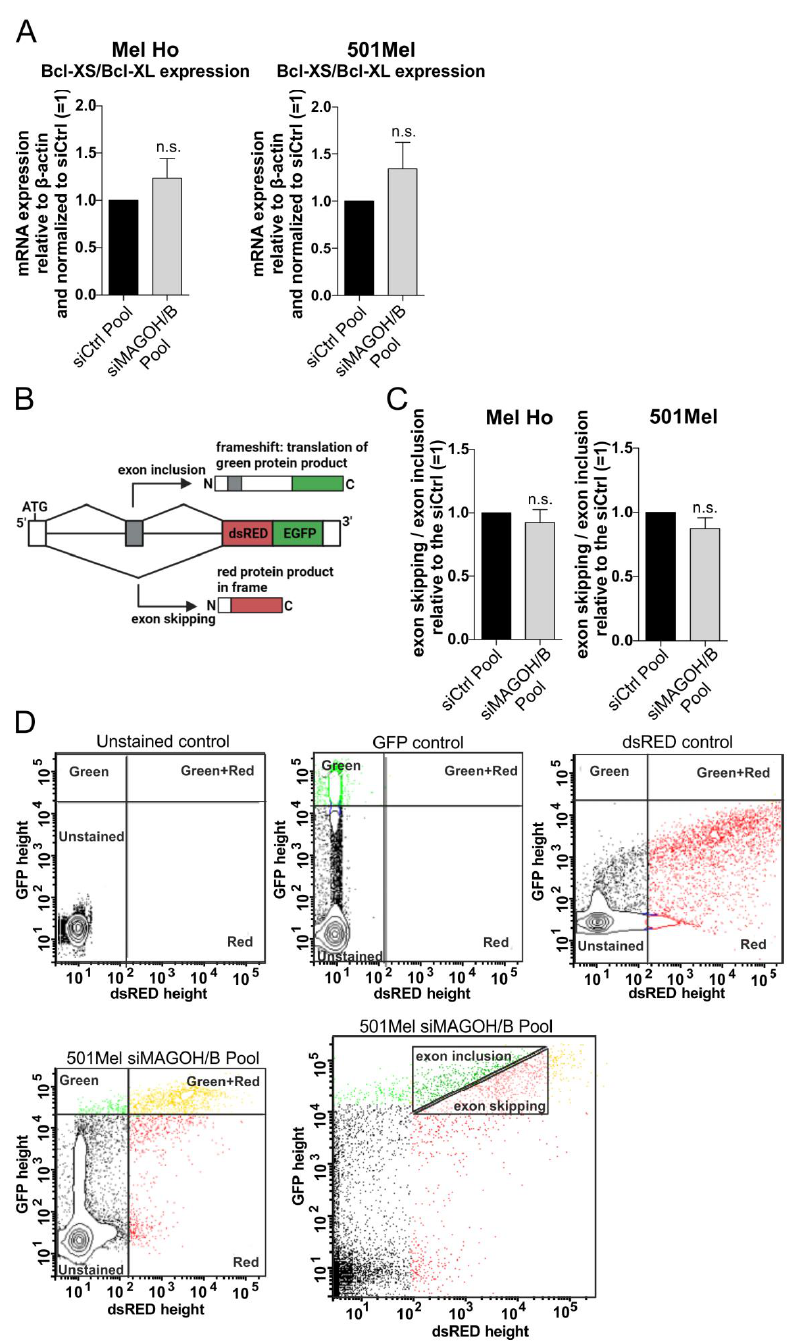
2 Figure 5. MAGOH and MAGOHB do not influence alternative splicing of pro-apoptotic Bcl-XS or exon skipping of a fluorescent splicing reporter in cutaneous malignant melanoma. ( A ) MAGOH